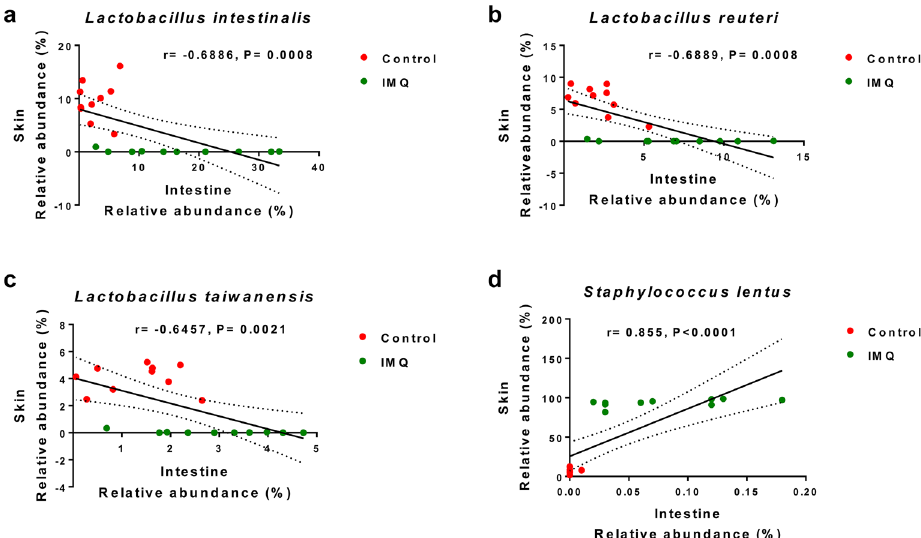
Figure 4. The correlations between bacterial relative abundance in the intestine and skin. ( a ) There was a significant negative correlation (r = − 0.6886, P = 0.0008) of the relative abundance of the species Lactobacillus intestinalis between the intestine and the skin. ( b ) There was a significant negative correlation (r = − 0.6889, P = 0.0008) of the relative abundance of the species Lactobacillus reuteri between the intestine and the skin. ( c ) There was a significant negative correlation (r = − 0.6457, P = 0.0021) of the relative abundance of the species Lactobacillus taiwanensis between the intestine and the skin. ( d ) There was a significant positive correlation (r = 0.855, P < 0.0001) of the relative abundance of the species Staphylococcus lentus between the intestine and the skin. The values represent the mean ± S.E.M. (n = 10).